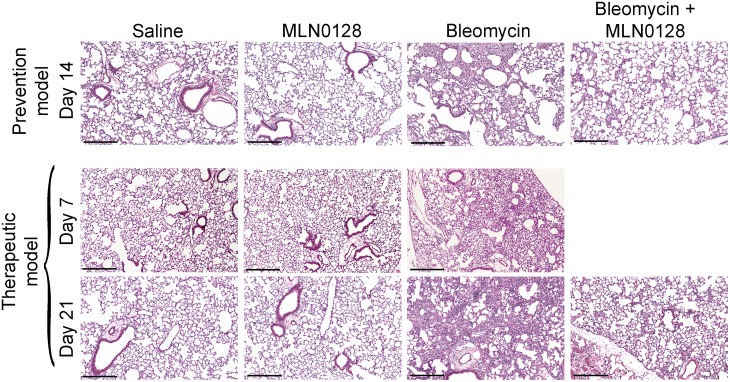
MLN0128 inhibits bleomycin-induced lung fibrosis.Mice were treated according to the schematic shown in Fig. 5A. Mice lungs were harvested at Day 14 (prevention model) or Day 21 (therapeutic model) followed by H&E staining. Scale bar = 100 micron.